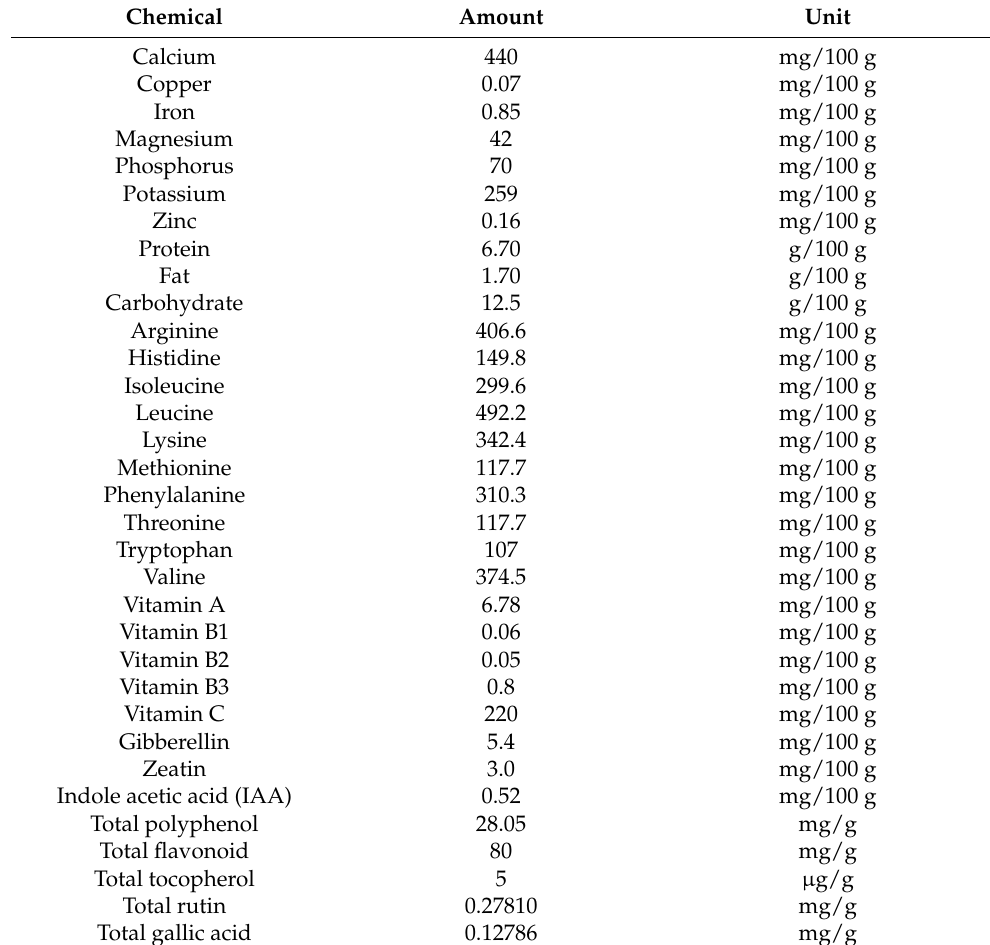
Table 1. Chemical composition of Moringa oleifera